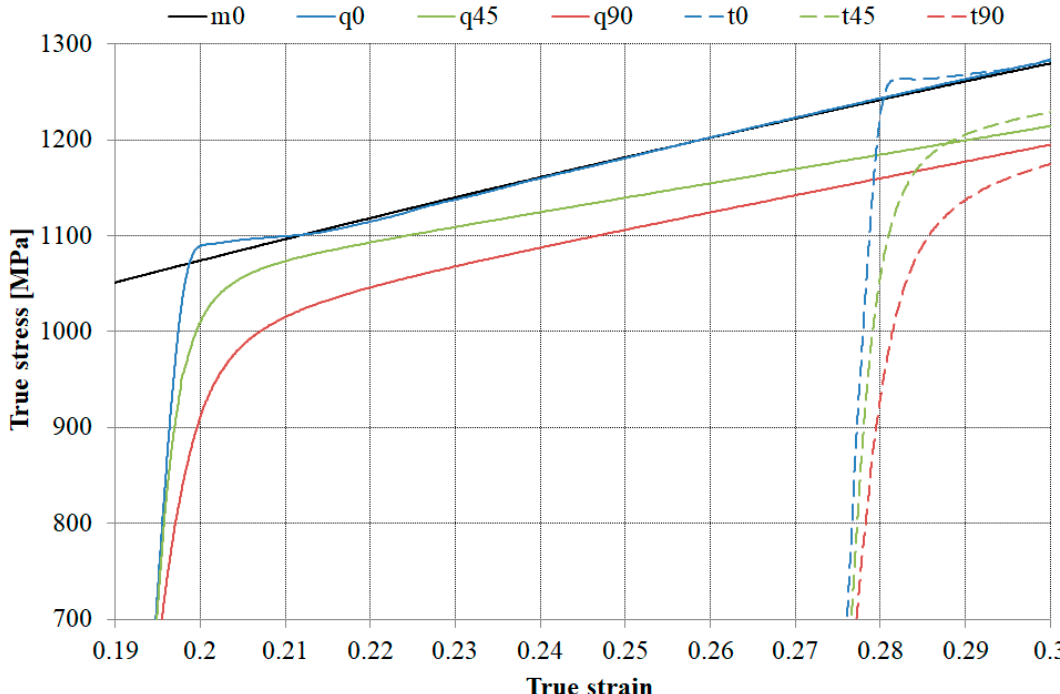
Figure 7. True stress–strain curves, showing, in detail, the yield plateau for a θ = 0° for 20% and 30% pre-loaded samples.